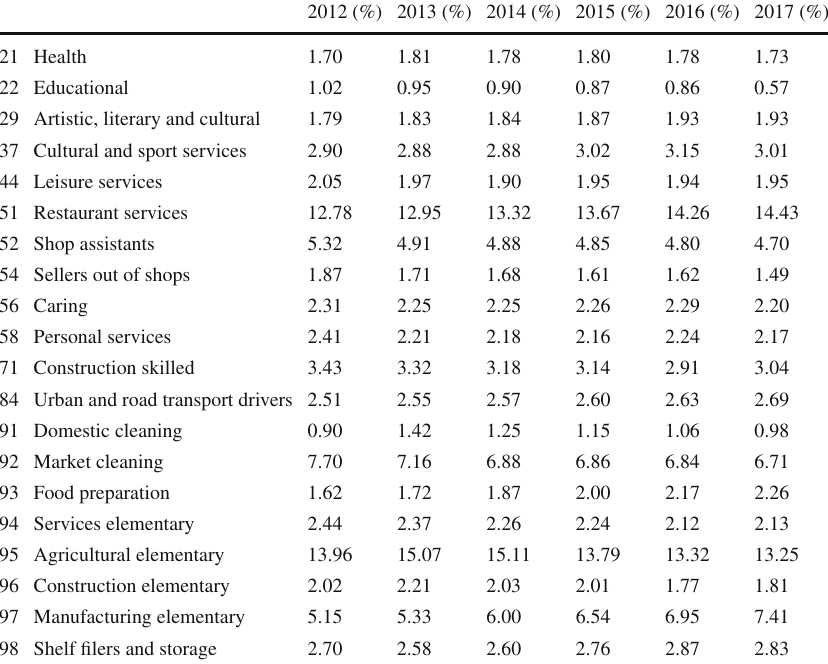
Table 9 New contracts at SEPE, by